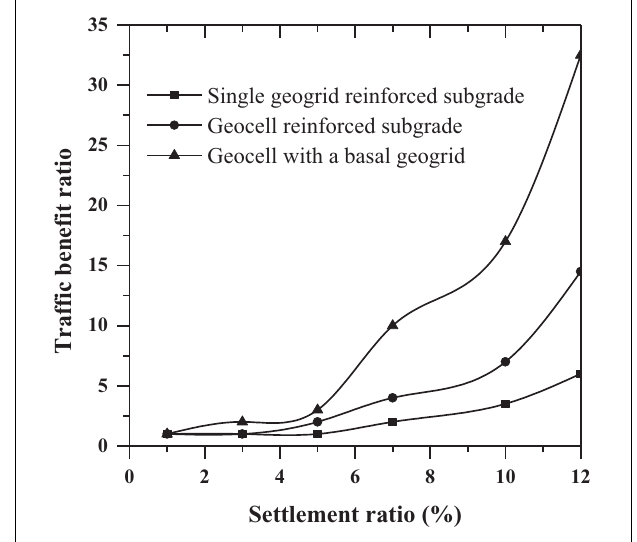
FIGURE 9 | Variation of traffic benefit ratio with settlement ratio.